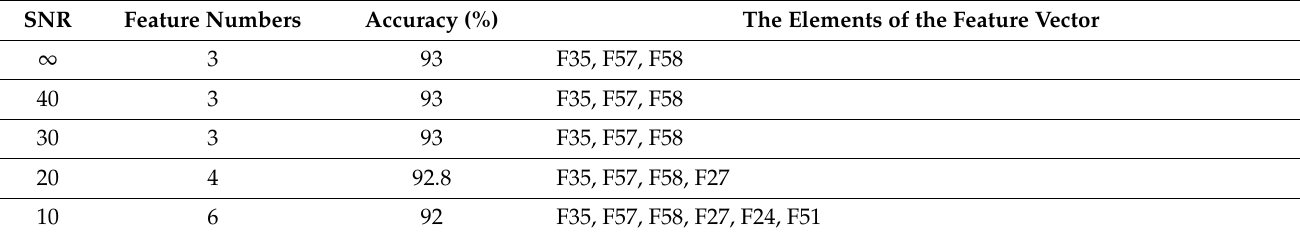
Table 7. Result of the